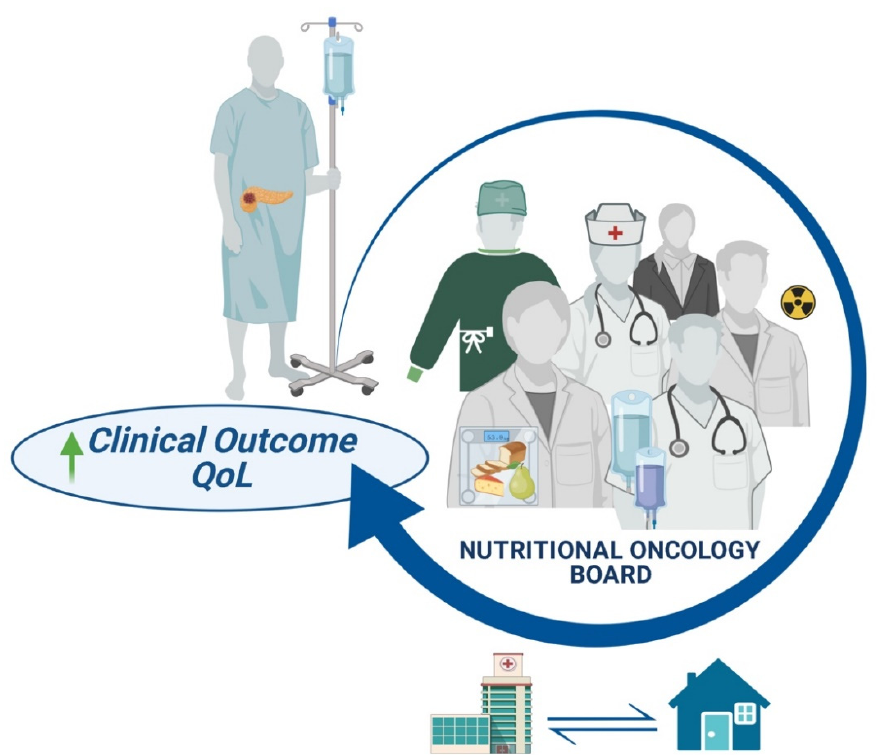
Figure 3. Multidisciplinary management of pancreatic cancer patients. Abbreviations: QoL, quality of life.